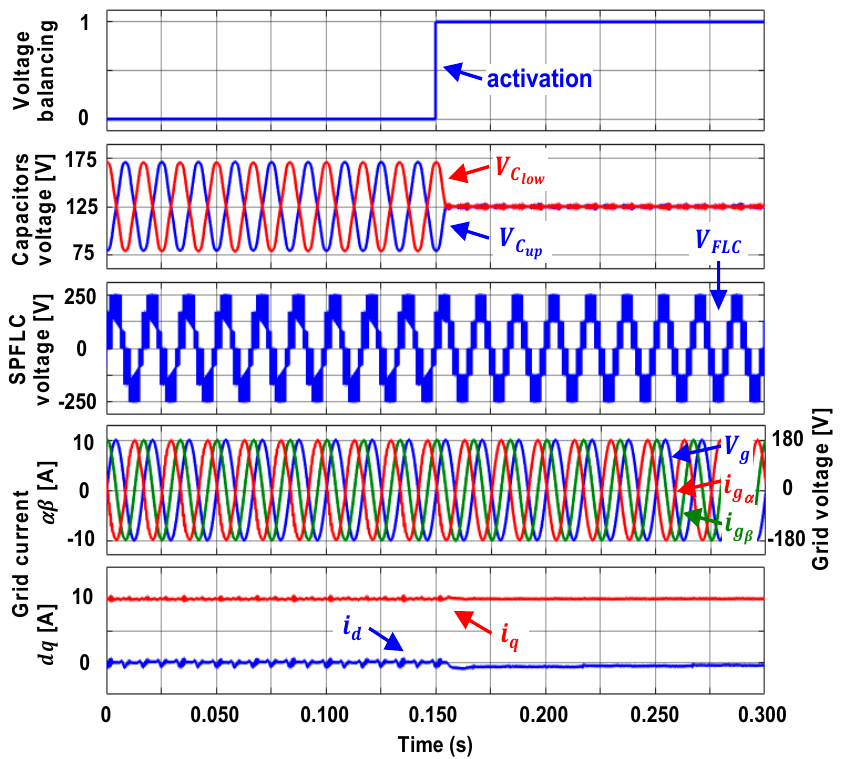
Figure 6. Performance of the voltage balancing strategy and the vector control for the proposed grid-tied SPFLC during steady state of the 𝑑𝑞 grid currents.